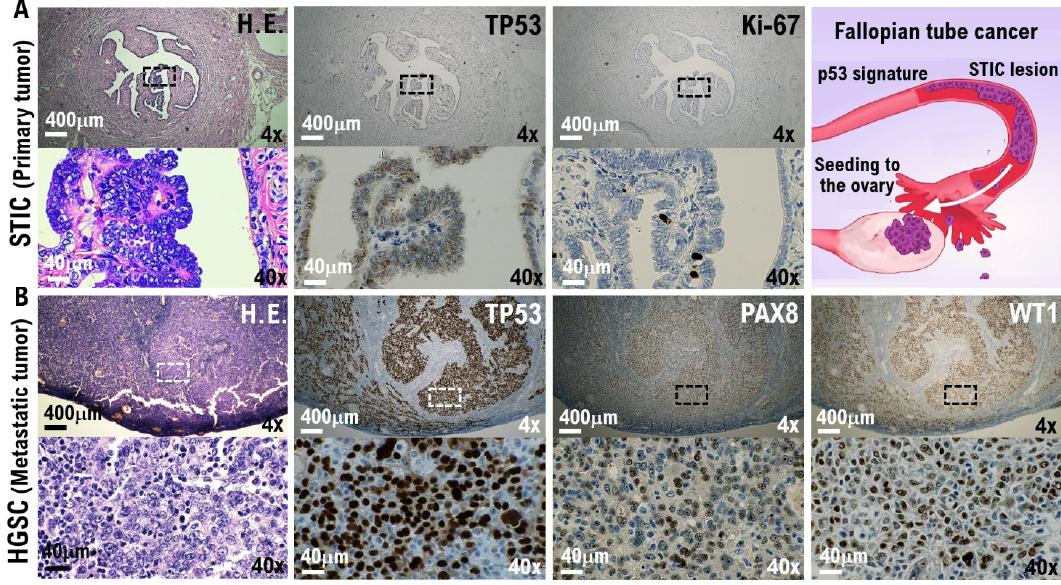
Figure 1. Molecular pathological evidence for the development of high-grade serous ovarian cancer (HG-SOC) in a patient with COVID-19. Molecular pathological analysis was conducted on the bilateral fallopian tubes and ovarian tissues removed from COVID-19 patients. To evaluate the resected ovaries and fallopian tubes, the fallopian tubes were longitudinally incised as per protocol and the fimbriated end (SEE-Fim) was extensively examined. The remaining ovaries and fallopian tubes were cut into 2–3 mm sections. Histopathological evaluation was conducted using these tissue sections. ( A ) The H.E. images show papillary and dendritic lesions forming in part of the fallopian tube. Enlargement of the image showing the diseased tissue reveals noninvasive growth of strongly atypical epithelium (H.E.). In the immunohistochemical staining results with appropriate monoclonal antibodies, TP53-positive and Ki-67/MIB1-strongly positive highly cellular atypical and nuclear atypical cells are observed in the left fimbriated end. Serous tubal intraepithelial carcinoma (STIC) and HG-SOC are found in the left fimbriated end. ( B ) The H.E. image shows growing solid tissue areas and papillary structures. Enlarging the lesion tissue reveals a narrow gap within the solid alveolus (H.E.). In the papillary nodule found on the right outer surface of the left ovary, PAX8-positive, WT-1-positive, and TP53-diffusely strongly positive highly cellular atypical and nuclear atypical cells are observed. High-grade serous carcinoma was found in the papillary nodule on the right outer surface of the left ovary. As shown in the panels, scales are 4 × and 40 ×